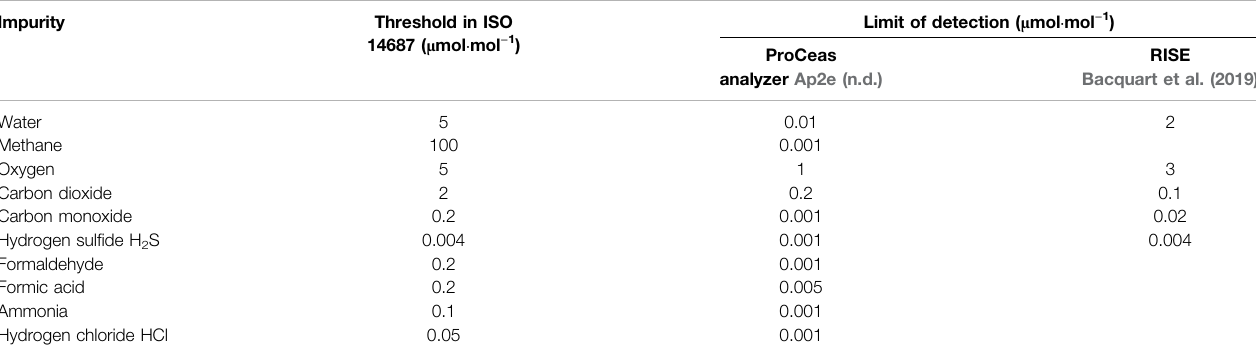
TABLE 7 | Detection limit per impurity with OFCEAS for manufacturer and